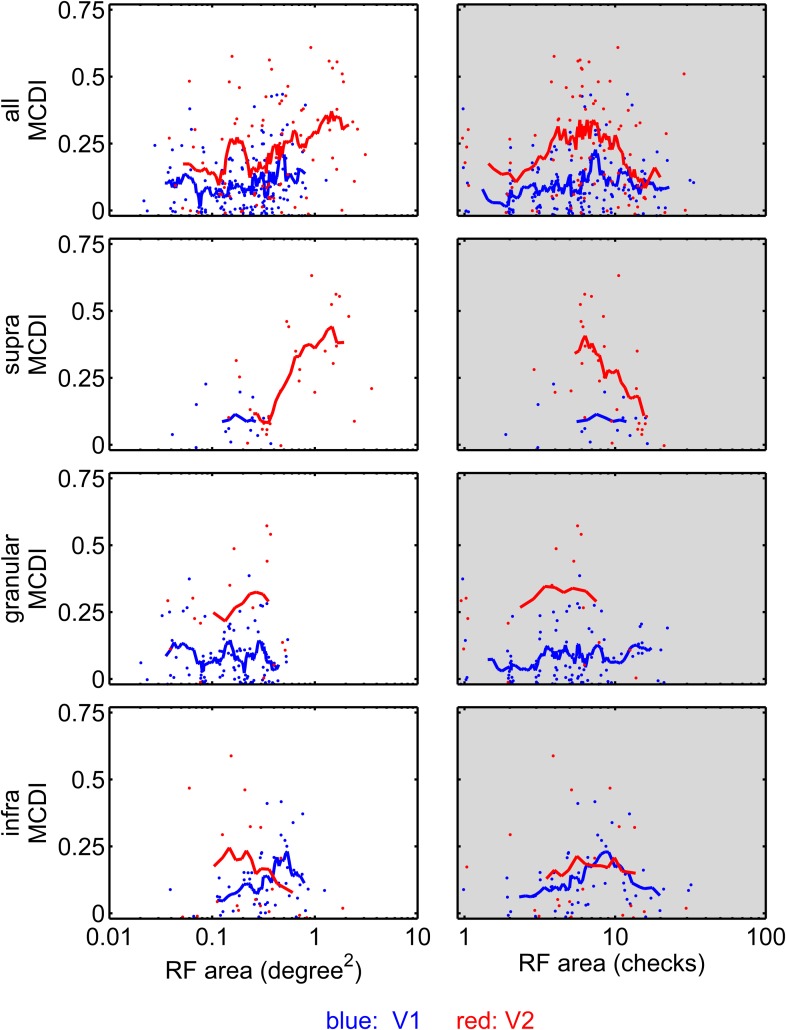
Sensitivity to multipoint correlations in V1 and V2 as a function of RF area and number of checks within the RF.Each point represents a neuron with a mappable RF (see ‘Materials and methods’): V1 in blue, V2 in red. Left: MCDI as a function of RF area, computed by counting the number of stimulus checks in the RF, and multiplying by the area of each check. Right: MCDI as a function of the number of checks in the RF. The solid lines indicate the moving average of 9 cells, ranked in order shown on the abscissa. Note that when neurons are equated for RF area, either in deg2 or in terms of the number of checks contained, the MCDI is higher in V2 than in V1. This holds across the population and in the supragranular and granular layers. In the infragranular layer, there appears to be a subpopulation of V1 neurons with large RFs and MCDI's that are greater than their counterparts in infragranular V2—though not as great as in granular and supragranular V2.